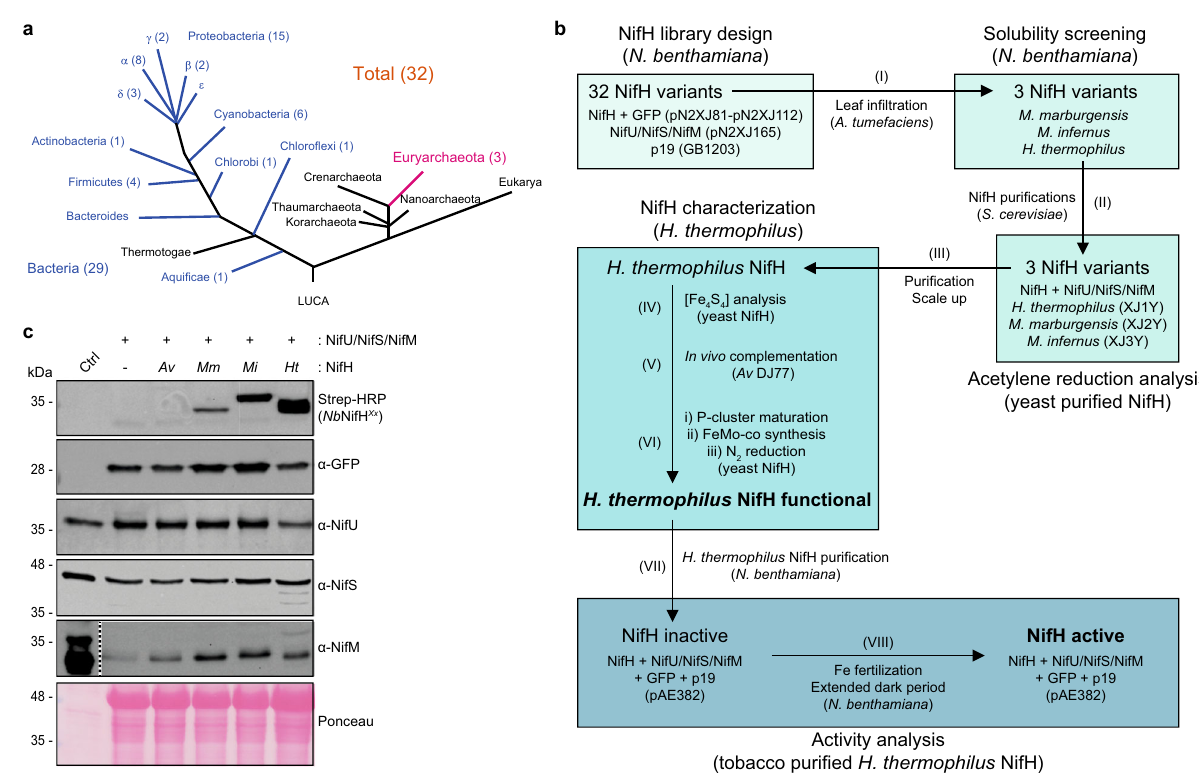
Fig. 1 NifH library design and screening. a Phylogenetic tree indicating the distribution and number of the tested NifH variants among bacterial phyla (blue) and archaeal lineage (magenta). b Experimental work fl ow of this study. c Immunoblots of N. benthamiana soluble protein extracts developed with antibodies against TS, GFP, NifU, NifS, and NifM (step I of panel b ). GFP detection was used as control to normalize effectiveness of in fi ltration experiments. Ponceau staining panel is shown as loading and membrane transfer control. Dotted line indicates different exposures of the same membrane. Cell-free extracts of A. vinelandii DJ (for NifU and NifS) or E. coli Rosetta (DE3) overexpressing NifM Av (for NifM, as NifM expression levels in A. vinelandii is low) were used as size controls. Uncropped immunoblots are shown in Supplementary Fig.